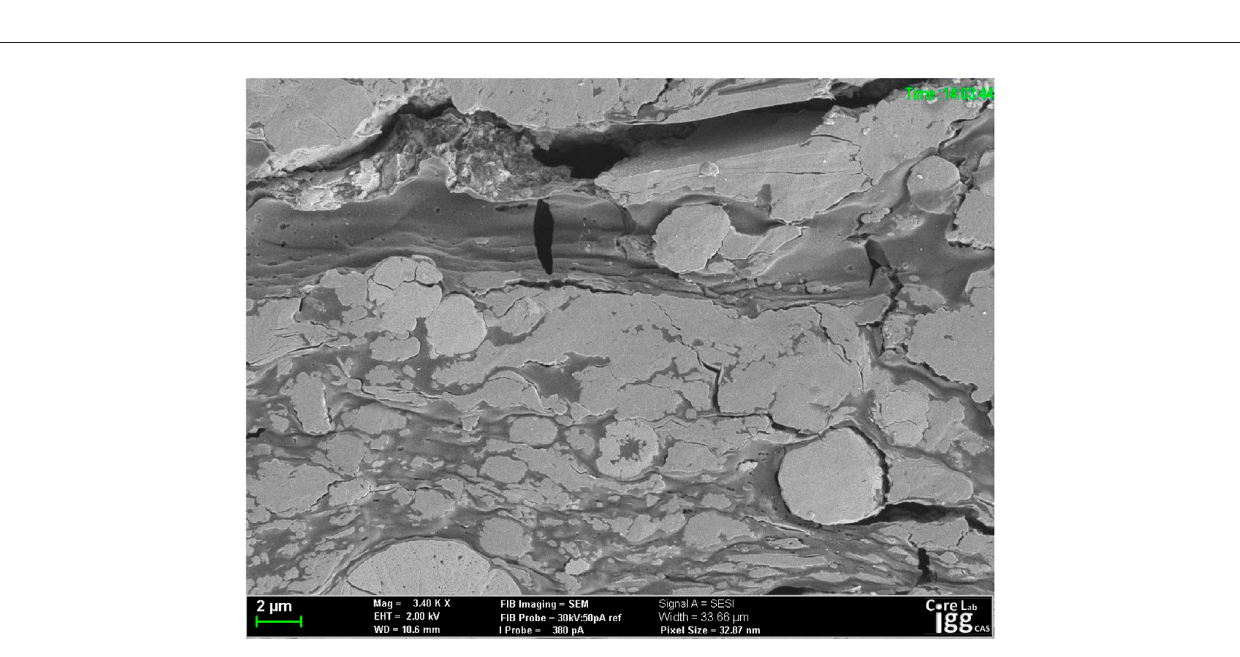
Frontiers in Earth Science |